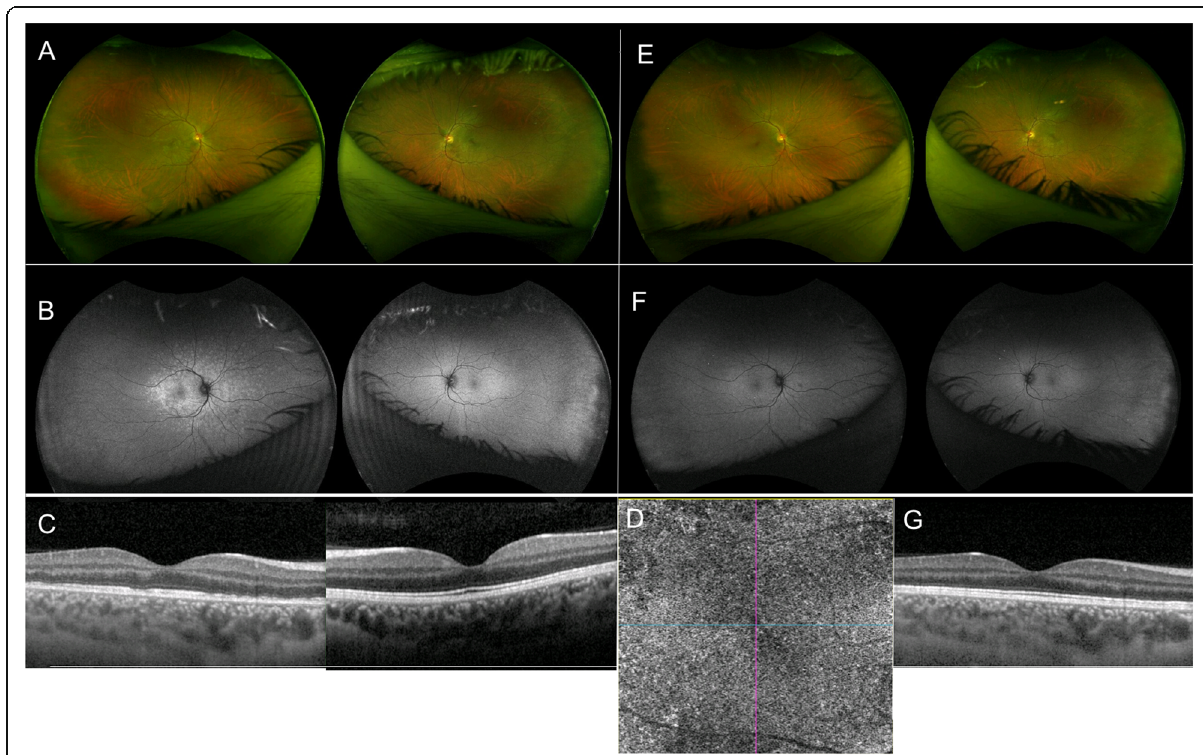
Fig. 1 Multiple evanescent white dot syndrome. A Right eye ultra-wide field color fundus photograph showing yellowish, deep retinal lesions, located at the posterior pole, extending to mid-periphery; Left eye unremarkable. B Right eye ultra-wide field fundus autofluorescence (FAF) showing corresponding hyperautofluoresecent lesions; Left eye unremarkable. C Right eye optical coherence tomography (OCT) showing marked disruption of the ellipsoid zone with hypertrophy of the underlying retinal pigment epithelium (RPE); Left eye unremarkable. D Right eye optical coherence tomography angiography (OCT-A) showing flow preservation within the choriocapillaris. E Right eye ultra-wide field color fundus photograph showing spontaneous resolution of the inflammatory lesions in 4 weeks with no sequelae. F Right eye ultra-wide field FAF showing normal fundus autofluoresecence findings. G Right eye OCT showing resolution of the outer retina